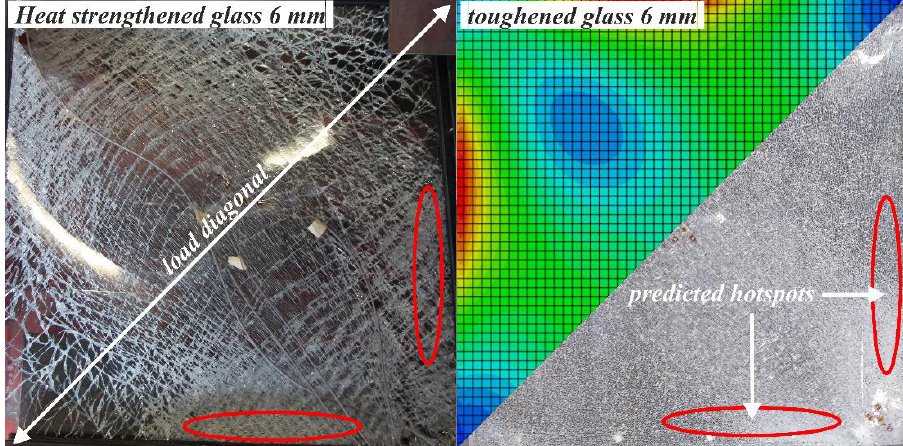
Fig. 11 Fracture pattern of (left) heat strengthened and (right) toughened glasses and the predicted stress